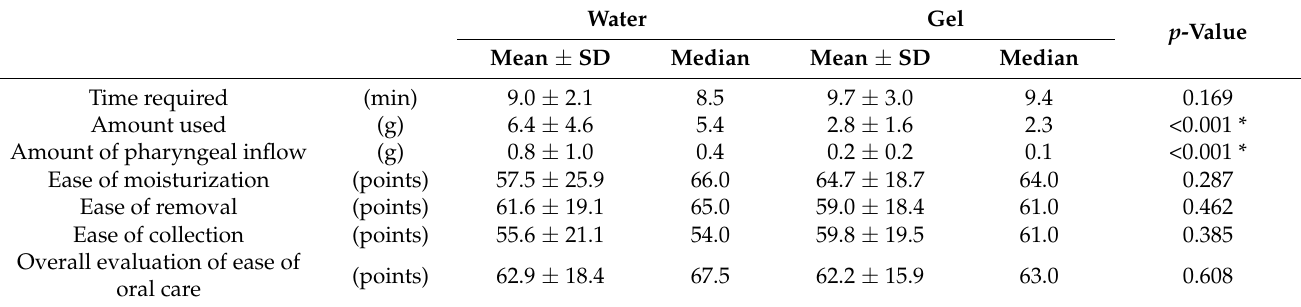
Table 2. Comparison of oral care with water and gel among dental professionals ( n = 48).